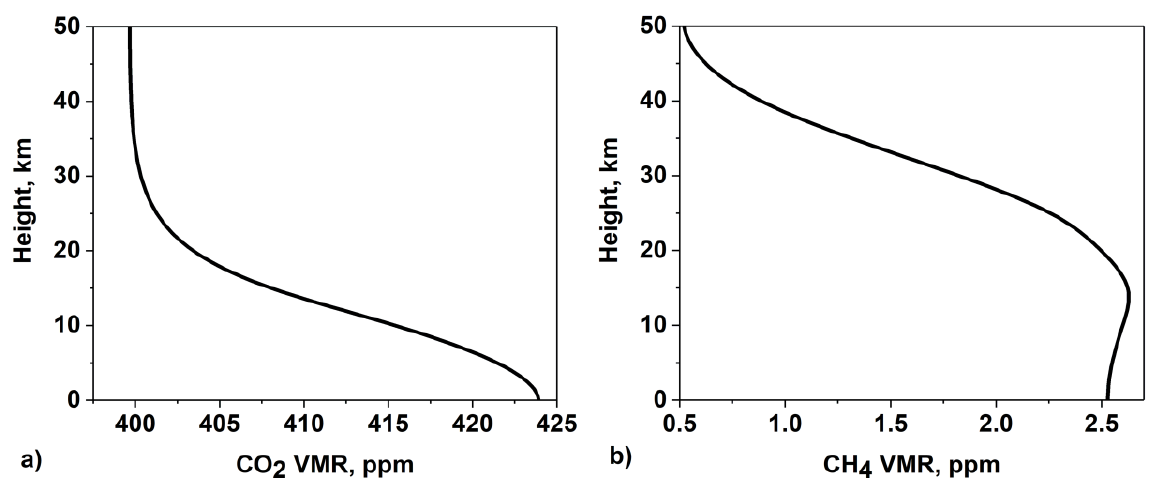
Figure 6. Vertical distributions of ( a ) CO 2 and ( b ) CH4 retrieved from measured atmospheric spectra, which are shown in Figure 5a,b, respectively. The vertical resolution of the retrievals is about half of the scale height.